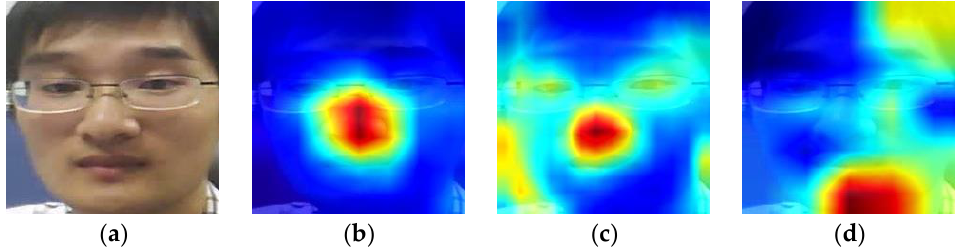
Figure 8. The visualization results of live face in the last layer network. ( a ) Original. ( b ) ResNet50. ( c ) VGG16. ( d ) InceptionV3.